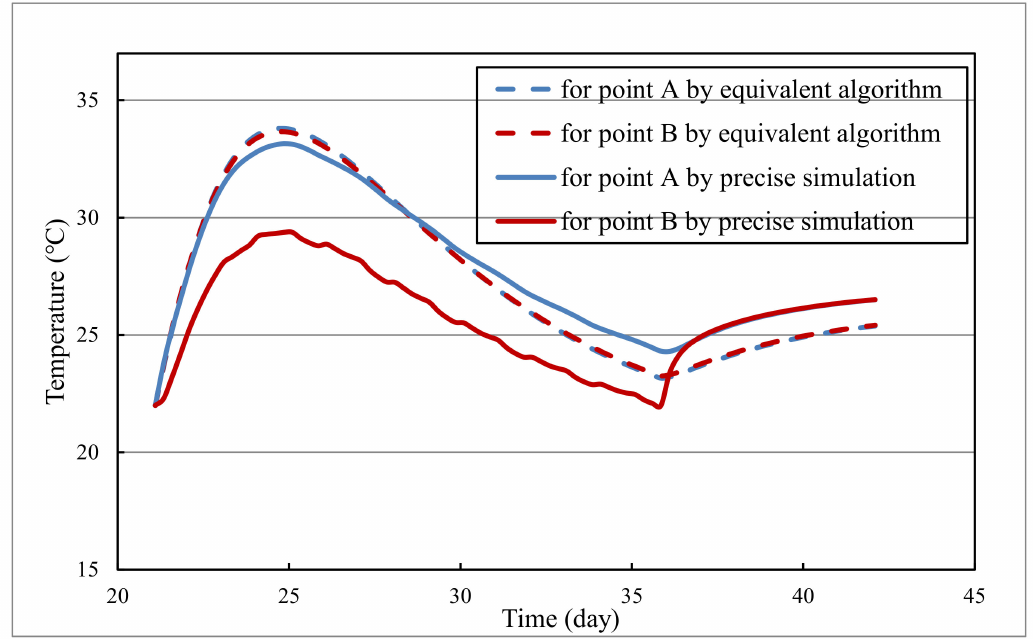
Figure 5. Temperature evolution of representative points A and